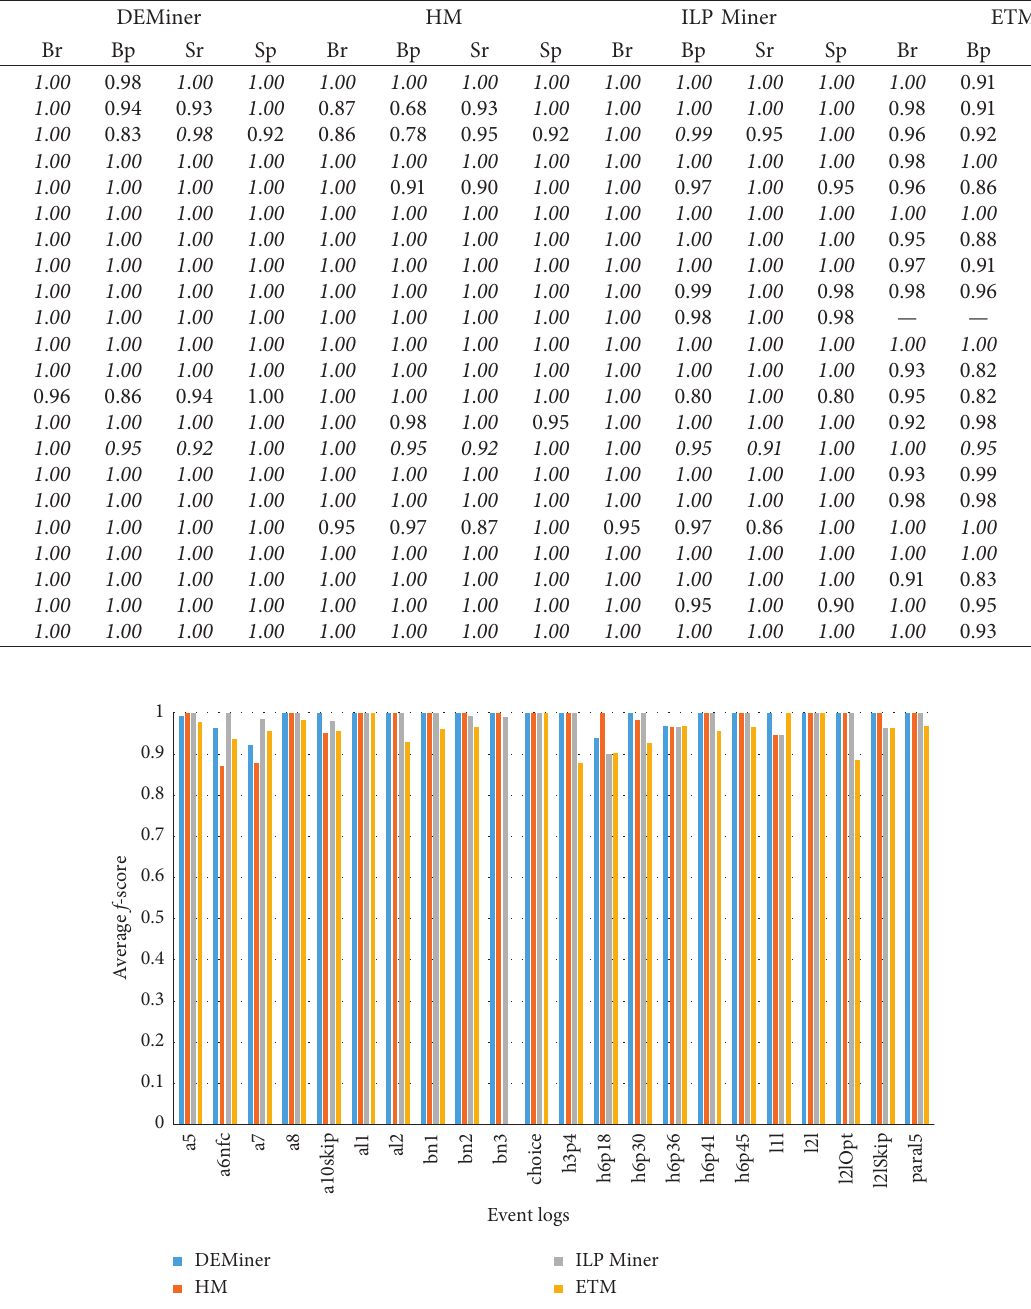
Figure 5: Average f -score of four algorithms on 22 event logs without